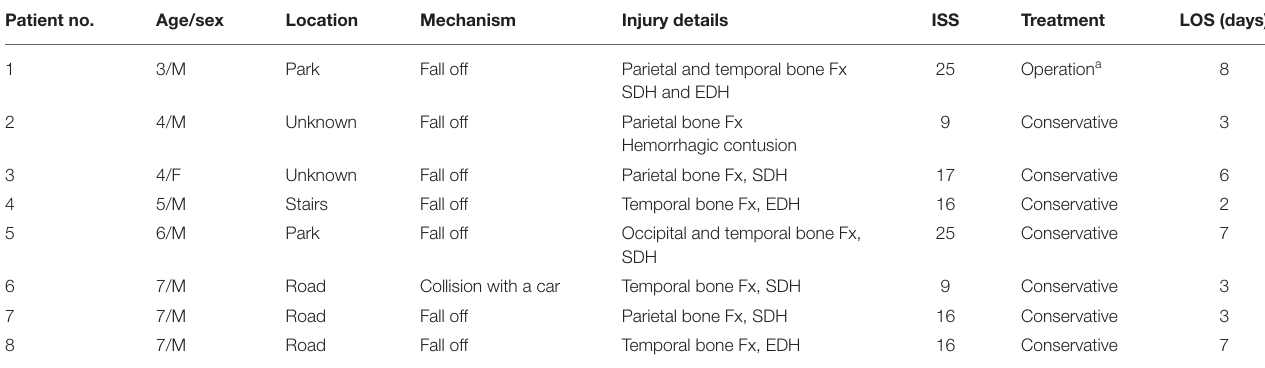
TABLE 3 | Eight patients with intracranial injury. Patient